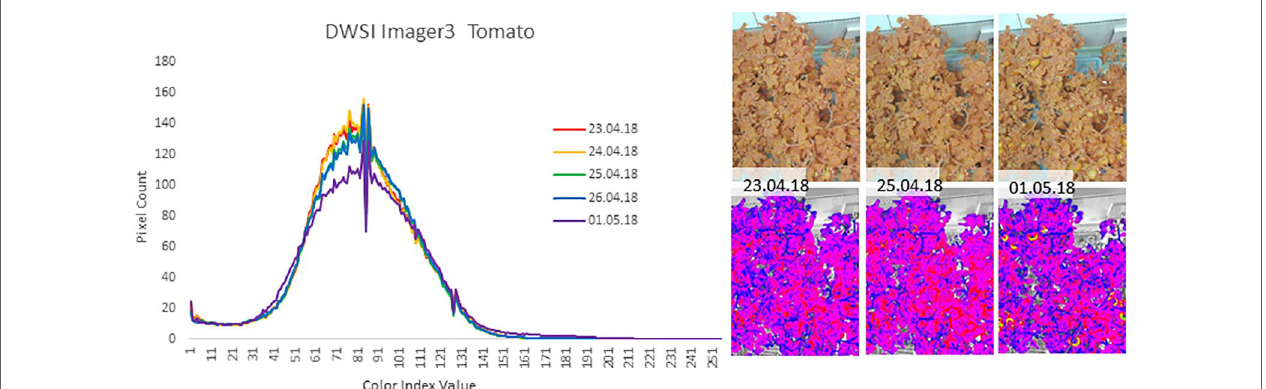
FIGUrE 12 | An example of plant suboptimal health indications from May of 2018 where the Dual Wavelength Spectral Imaging System (DWIS) recorded an anomaly in the health of one of the trays of tomato plants in the FEG. The graph depicts the count of pixels within the image of a particular NDVI value (Beisel et al., 2018). The Y axis is the number of pixels of each NDVI value, normalized to a range from 1 to 256. From April 23 to 25 2018, the pixel values begin to drop and shift to higher NDVI values and reach a maximum change near May 1. The images to the right show portions of the unprocessed image (top) and the corresponding false color NDVI image (bottom) for each of the given imaging days. The graphs were obtained from equal regions of interest out of each NDVI image such that non-plant parts of the image were not included in the pixel value counts.